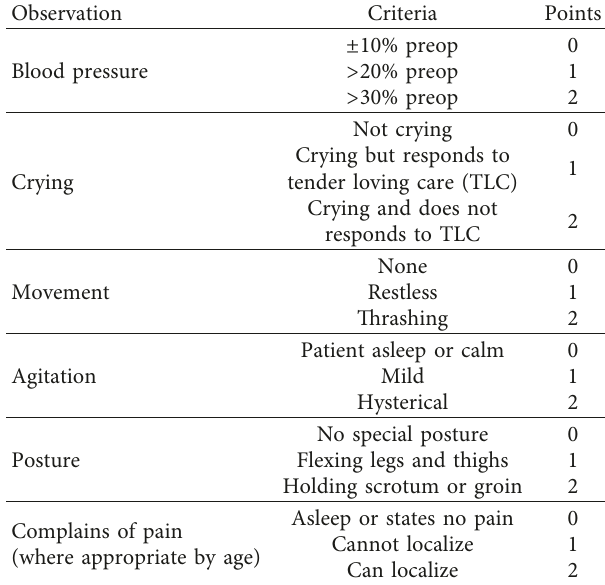
Table 2: Modified Hannallah pain score (MHPS)